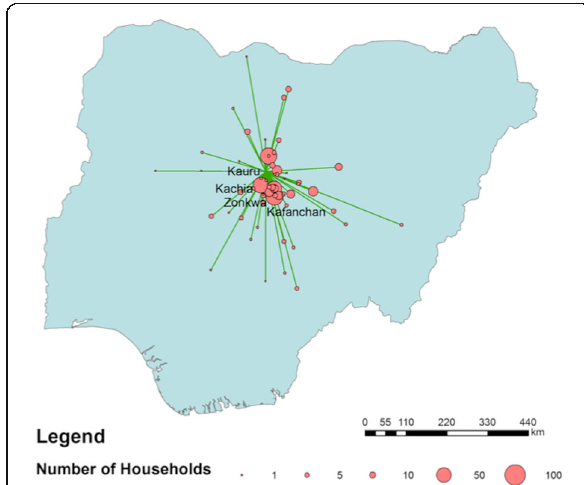
Figure 7 Map showing areas from which households have migrated